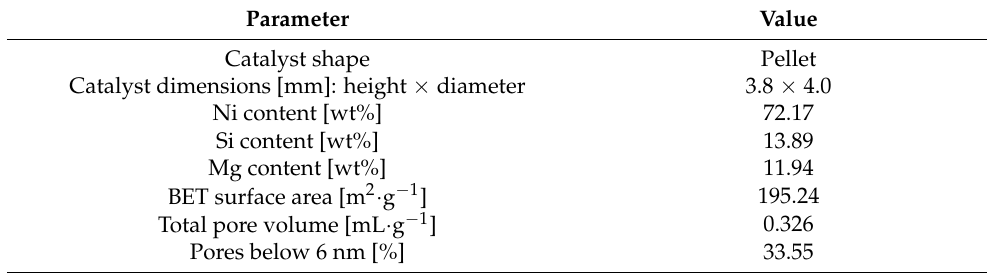
Table 2. Description of the fresh commercial Ni-based catalyst, XRF analysis, and BET analysis results. Parameter Value Catalyst